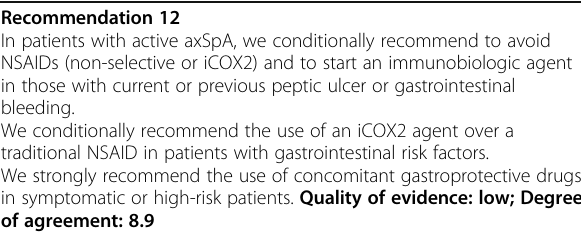
Table 3 Incidence of adverse events associated with traditional NSAIDs or iCOX2 compared to placebo in patients with axSpA: meta-analysis of randomized clinical trials Adverse events Severe adverse